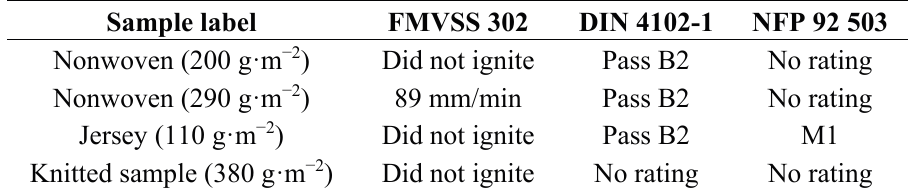
Table 3. Flame retardant performances of textiles samples. Sample